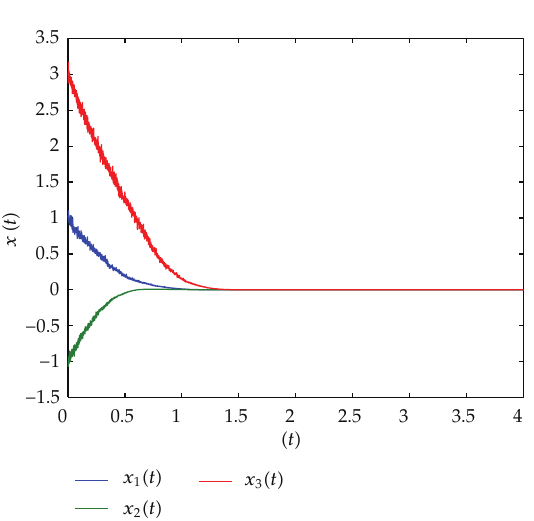
Figure 2: Trajectories of SNN (cid:2) 4.1 (cid:3) under the controller (cid:2) 4.3 (cid:3) with k 2 (cid:8) 1 in Example